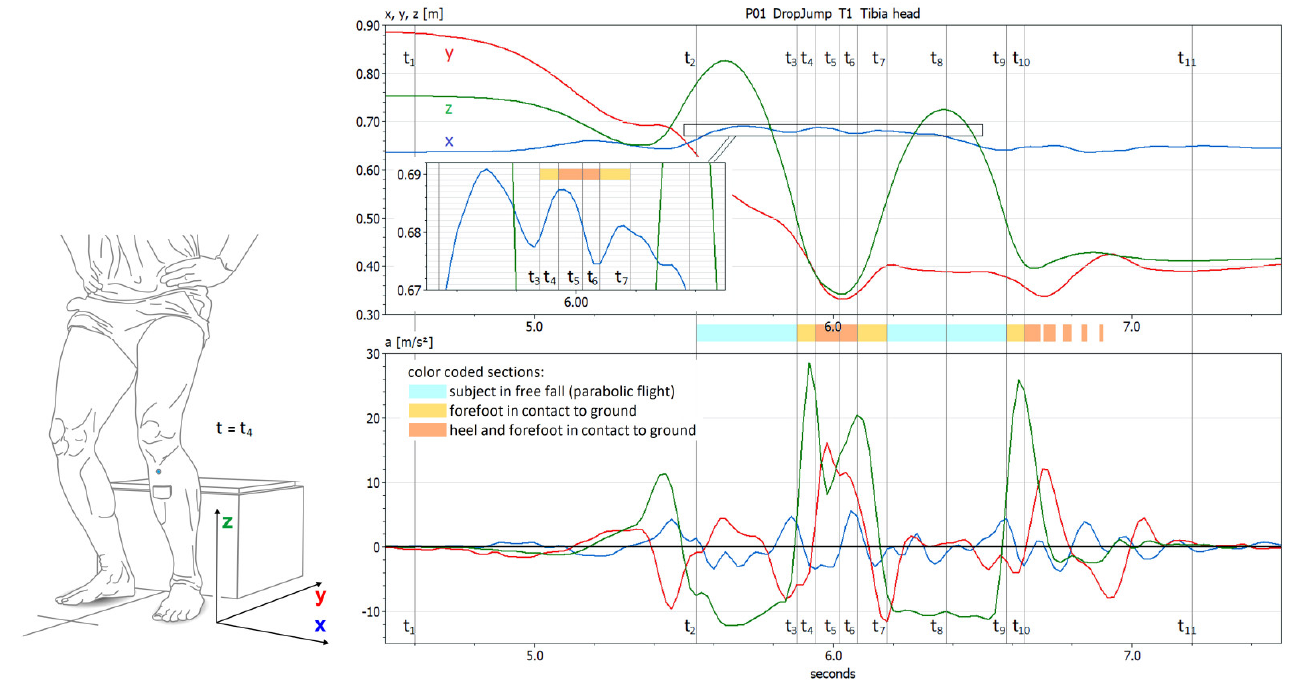
Figure 4. Test 7 Drop Jump. Focus of the measurement: the mediolateral movement of the tibia head (blue curves). Upper diagram: 3D coordinates (x, y, z) of the tibia head marker measured by the video-MA. Lower diagram: acceleration (a x , a y , a z ) of the tibia head marker determined by double derivation of the coordinates. Events t i are characteristic moments of the motion pattern such as forefoot or heel touch down. In the example shown, the tibia head shifts during landing between t 4 and t 6 (the foot lies flat on the ground) by 13 mm towards the medial.